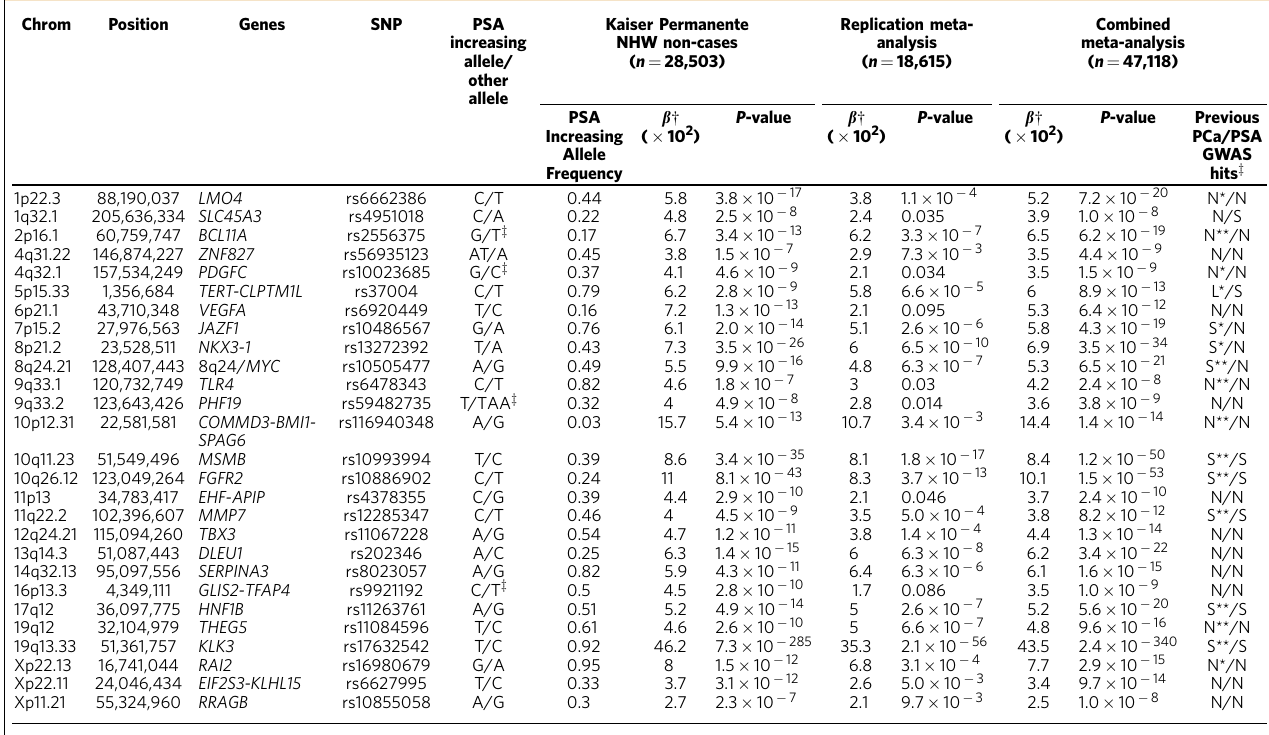
Table 2 | Unconditional genome-wide association study